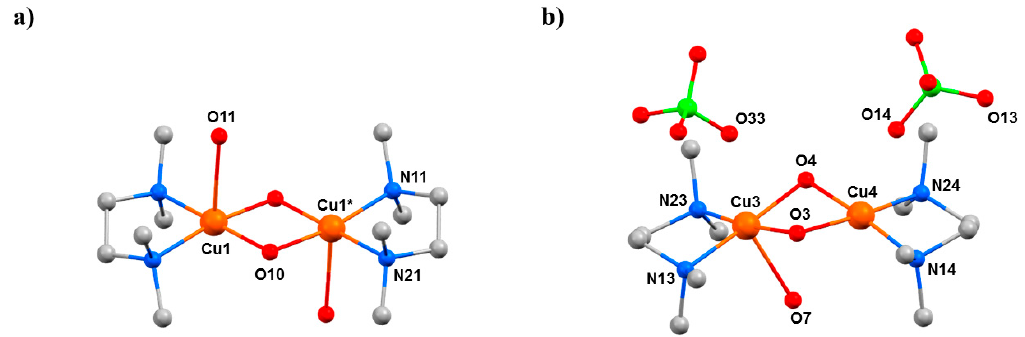
Figure 13. The molecular structure of complex 9 at ( a ) 0.25 GPa and ( b ) 2.5 GPa. Colour code: Cu = orange, O = red, N = blue, C = grey, Cl = green. H atoms (and counterions in ( a )) are omitted for